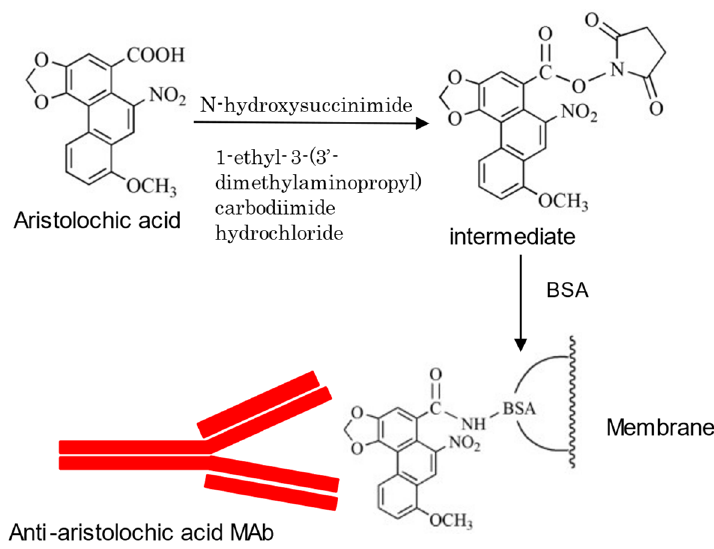
Figure 6. Eastern blotting approach for aristolochic acid (author’s unpublished data).